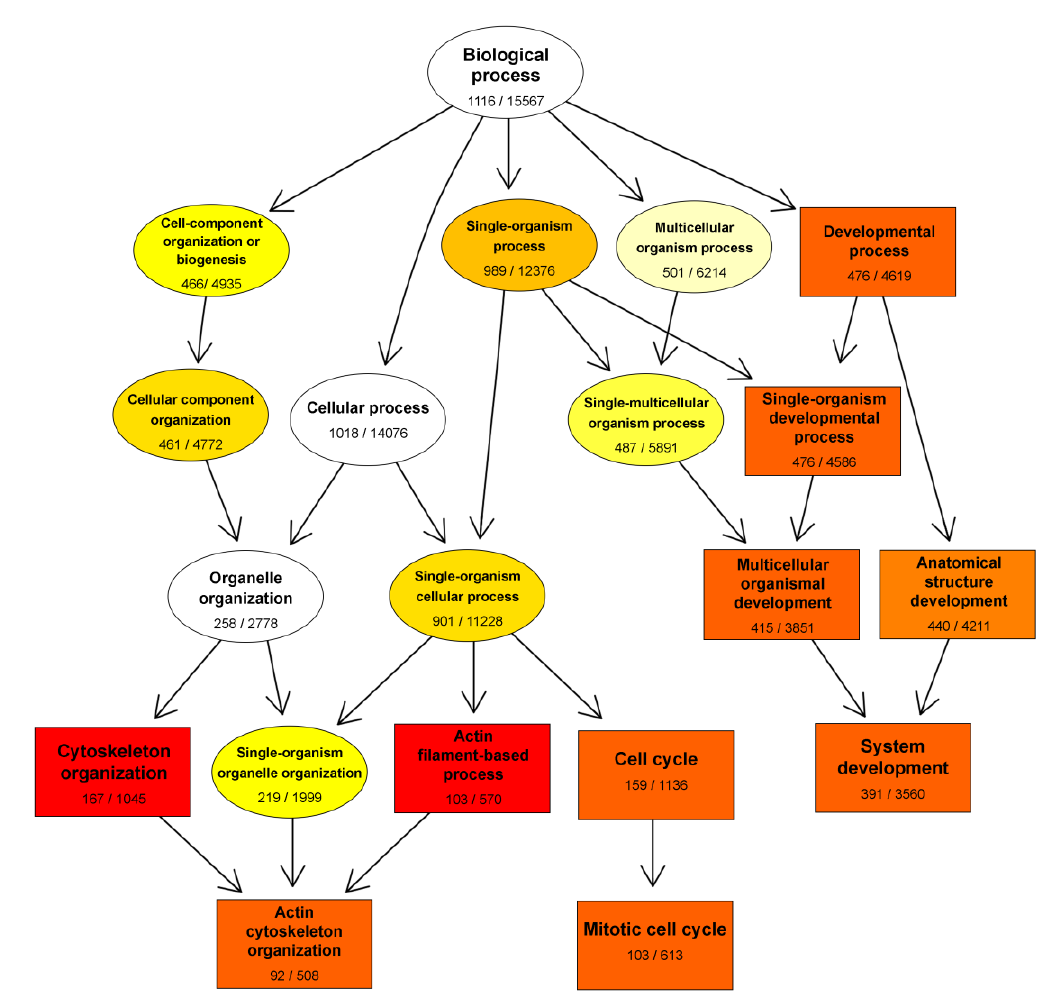
Figure 4. Directed acyclic graph (DAG) of GO terms enriched with downregulated DEG. This DAG represents the hierarchical relationship between biological process GO terms enriched with downregulated DEG from the comparison M1vsD10. Each node represents a GO term and branches represent the containment relationships and the degree of colors represent the extent of enrichment, with black and white ellipses representing non-significant enrichment and yellow to red representing the gradient from higher to lower p (adj) values. The numbers under the GO terms are the ratio of downregulated DEG annotated with that term over the number of genes annotated with that term in the reference database. Top 10 of significantly enriched terms are represented in boxes and the rest in